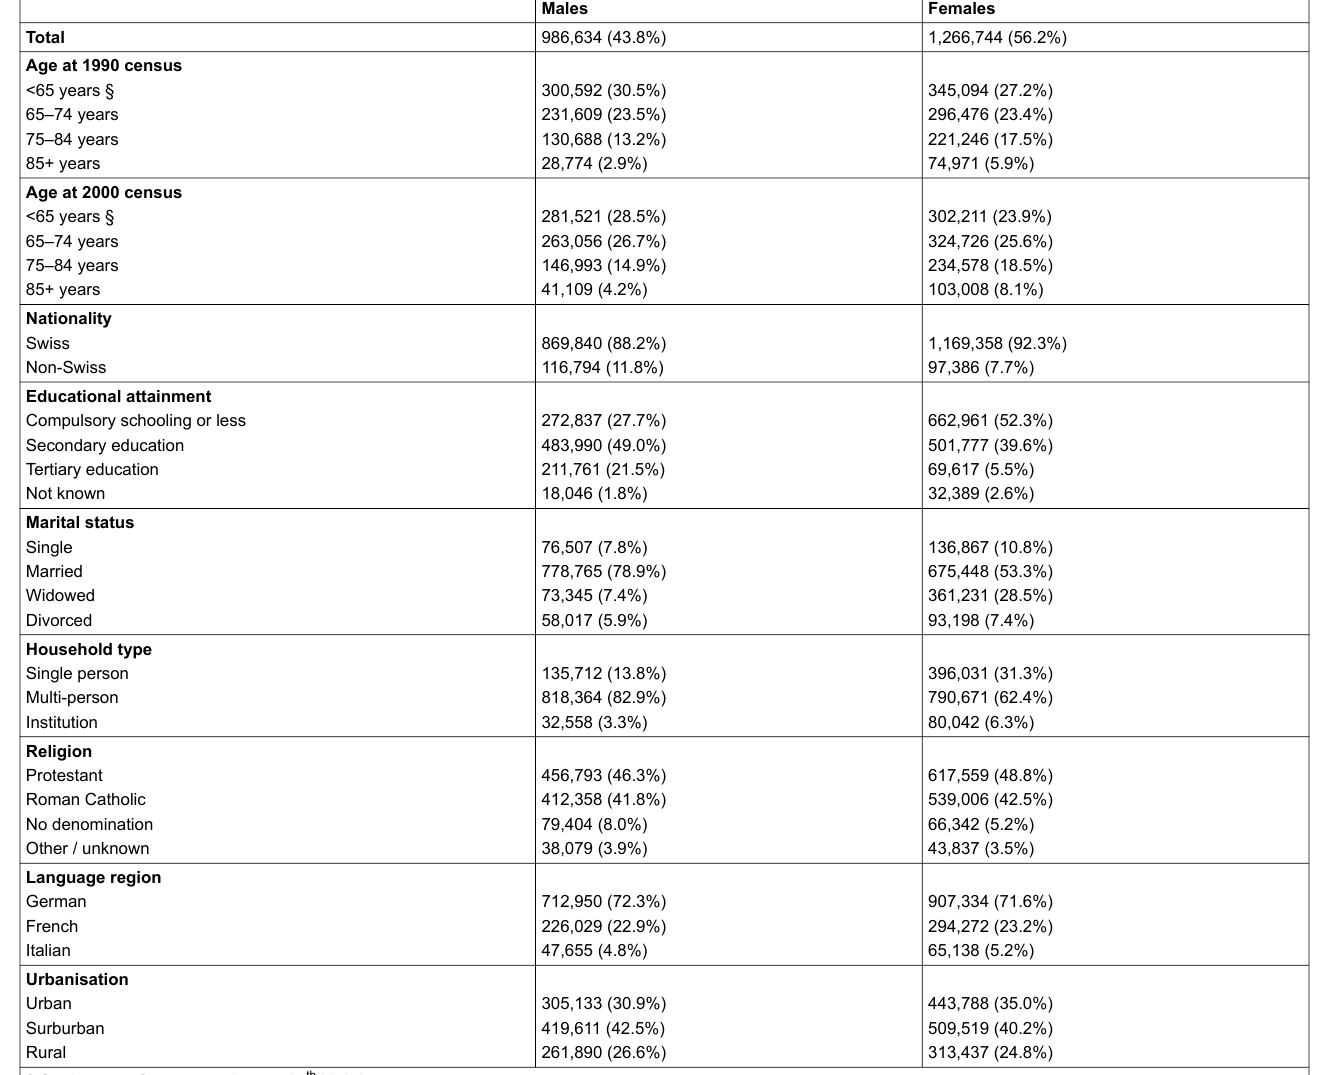
Table 1: Characteristics of the analytical study population (older Swiss adults ≥65 years old),